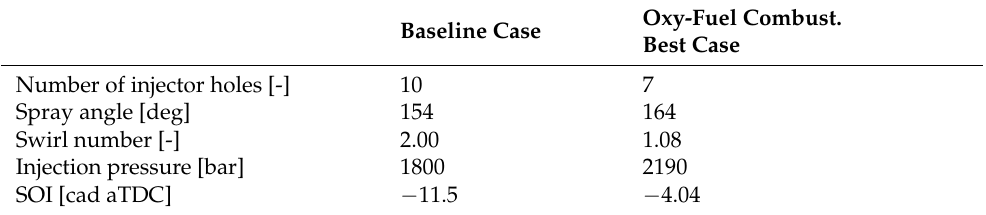
Table 8. Input comparison between the baseline and optimized oxy-fuel combustion cases